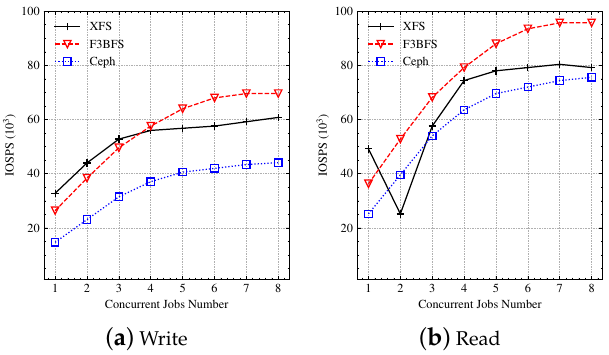
Figure 6. IOSPS evaluation for sequences IO.